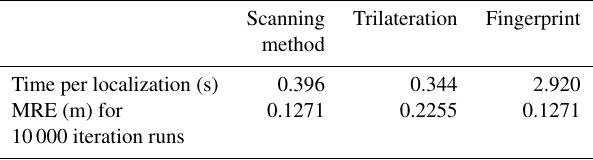
Figure 5. Distribution of the reconstruction error (RE) in the room under noisy conditions and SNR = 103dB using the scanning method (a) and trilateration (b) . The unit of the color bar is